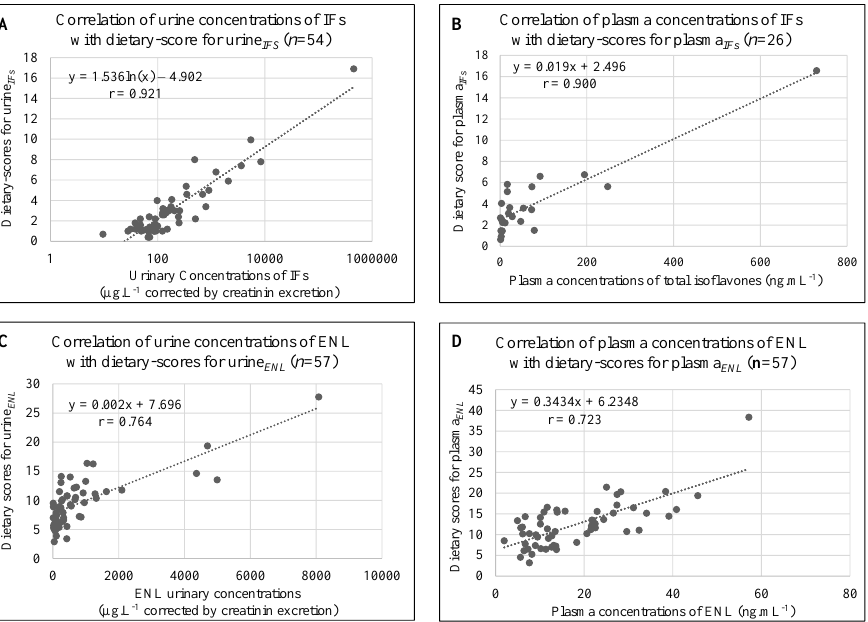
Figure 2. Correlations between IFs (genistein + daidzein + equol) or ENL (enterolactone) in biological fluids and their respective dietary scores.